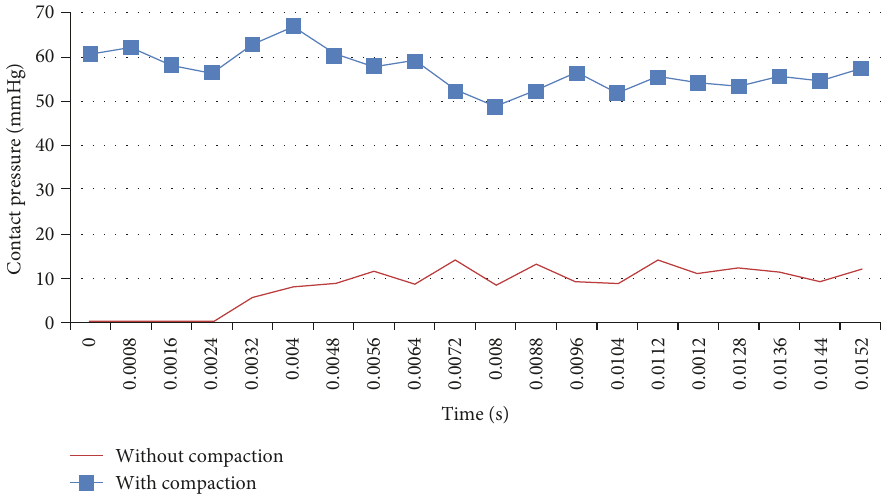
Figure 7: Von Mises stress and distal end displacement of the stent (without compaction).